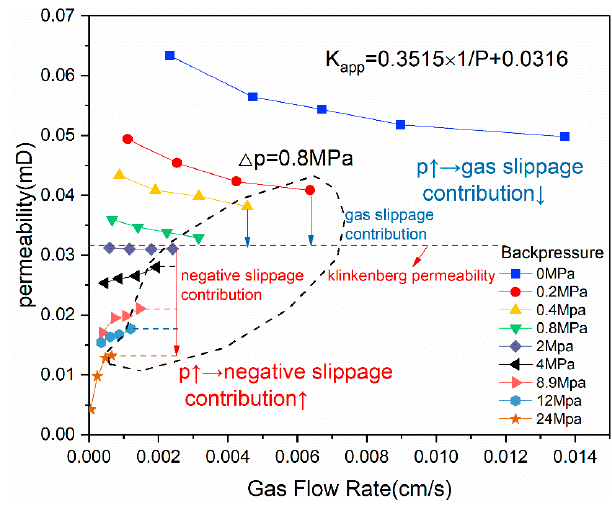
Figure 6. Permeability versus flowrate at diverse backpressures for core Z3.